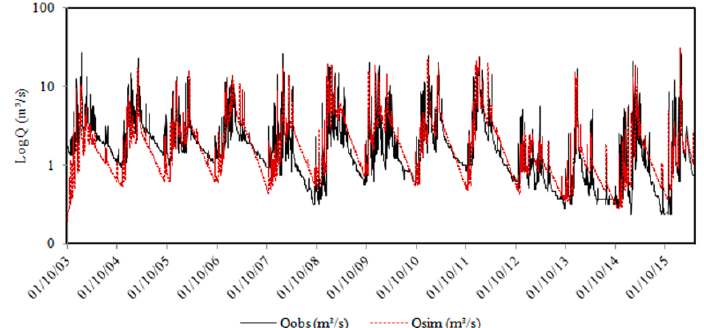
Figure 3. Hydrographs observed (Qobs) and simulated (Qsim) stream flows at the outlet of the Jequitibá River Basin. Table 6. Results of hydrological model (JAMS J2000) performance analysis (values in %).